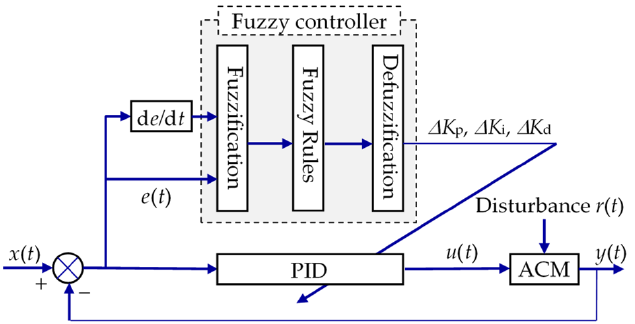
Figure 11. Parameter self-tuning fuzzy PID control block diagram.